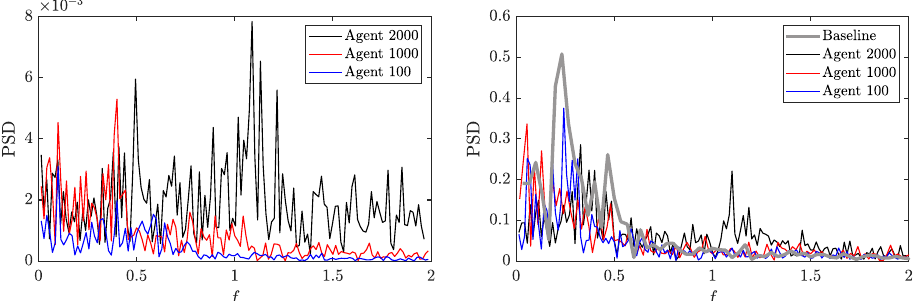
Figure 20. Power-spectral density of the action output, Q , for the Re = 2000 case, with its own policy and two cross-application policies ( left ) and for pressure in the probe near the cylinder in the separation zone ( right